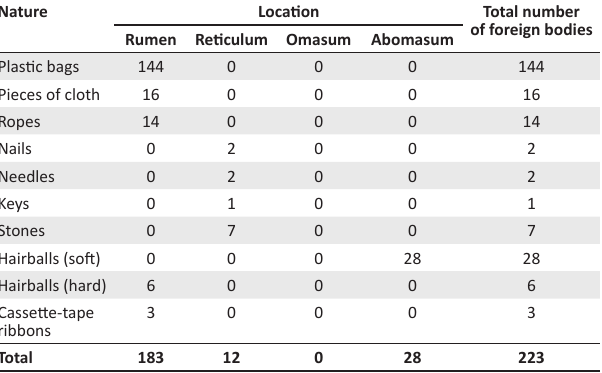
TABLE 6: Occurrence of foreign bodies according to their nature and location.